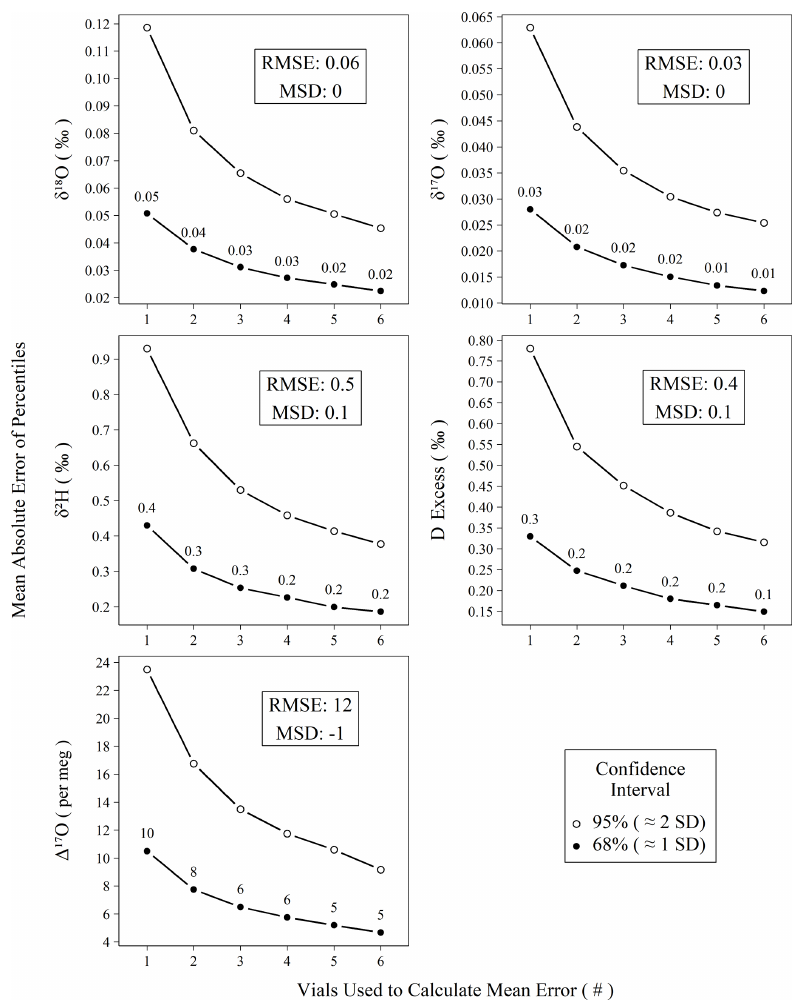
Figure 6. Mean absolute error of calibrated standards for isotope measurements versus the number of vials averaged prior to mean error calculation. All measurements of control and drift standards ( n = 896) were subtracted from their accepted values, resampled ( n = 100000) without replacement into replicates of varying (1–6) size, and summarized as means to create probability distributions of mean errors. Confidence intervals (68% and 95%) were calculated for the probability distributions, and the mean absolute values of their percentiles are plotted against their replicate size. The two intervals chosen, 68% and 95%, roughly correspond to 1 and 2 standard deviations,